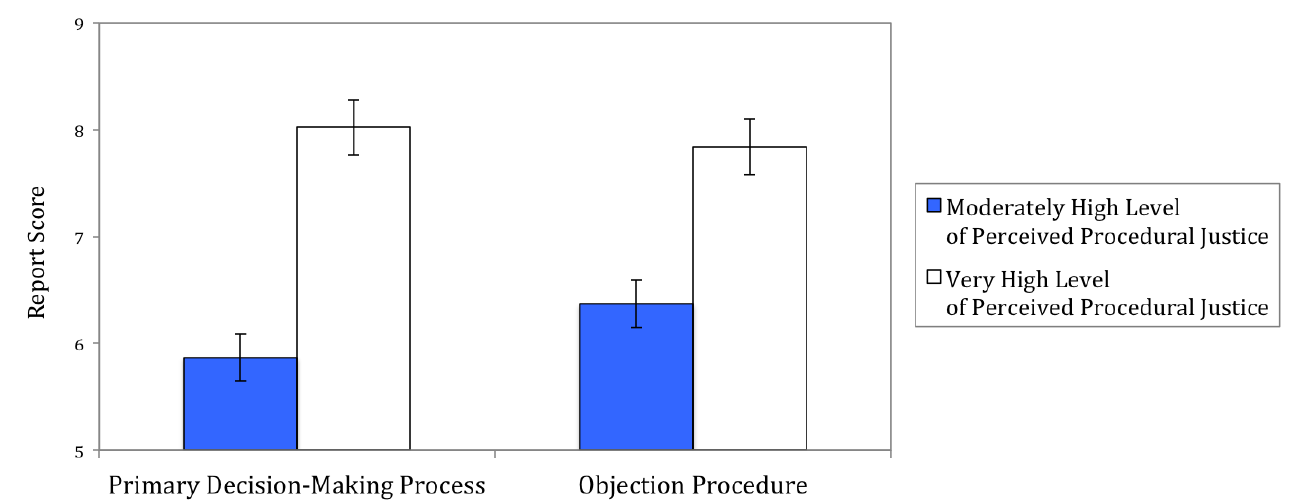
Figure 6 . Report scores awarded by citizens for the handling of their case as a function of their perceptions of procedural justice (moderately high level [-1 SD ] versus very high level [+1 SD ]) and the phase in which the case was handled (primary decision-making process versus objection procedure). Scores are on 10-point scales with higher values indicating higher scores of how the case was handled. Error bars represent standard errors of the